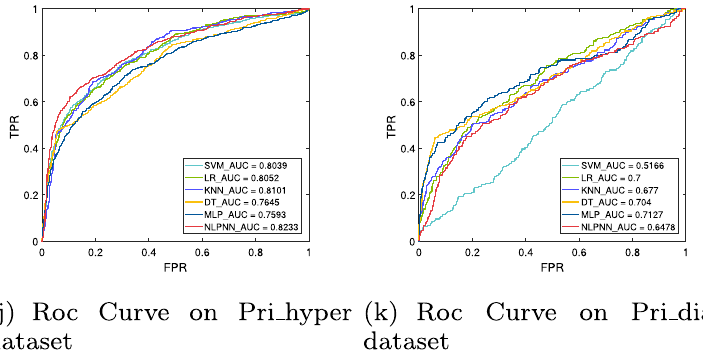
Figure 3. ROC curves of different algorithms with the corresponding AUC values on chronic disease